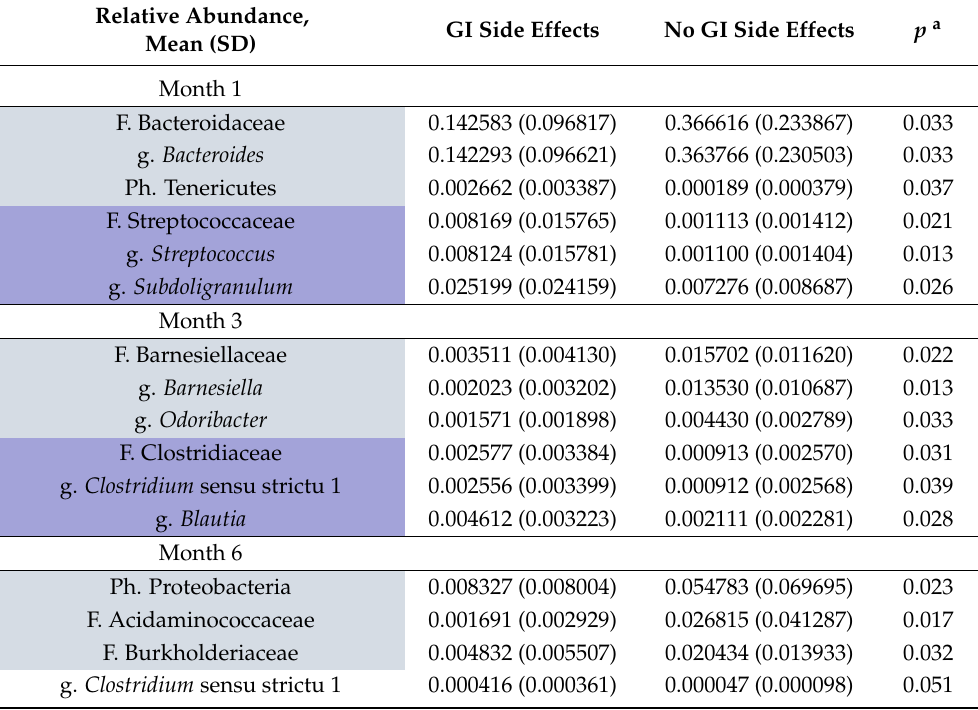
Table 4. Microbiota composition (expressed as relative abundance and SD) by gastrointestinal side effects during follow-up. The microorganisms in light gray are lower in subjects with side effects, and those in purpleare